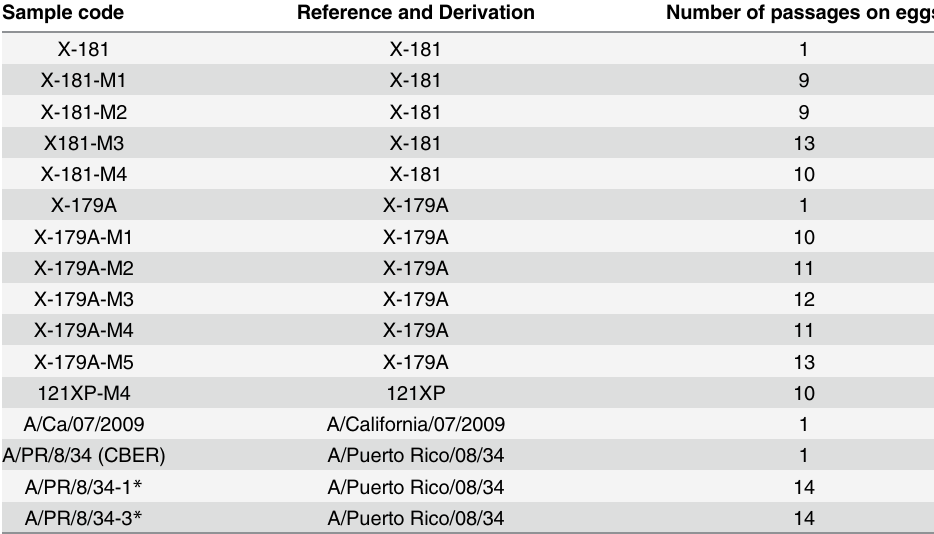
Table 1. Viruses of A/California/07/2009 vaccines, and A/PR/8/34 and wild type A/California/07/2009 viruses used for deep sequencing analysis. Note: CBER: Center for Biologics Evaluation and Research at US Food and Drug